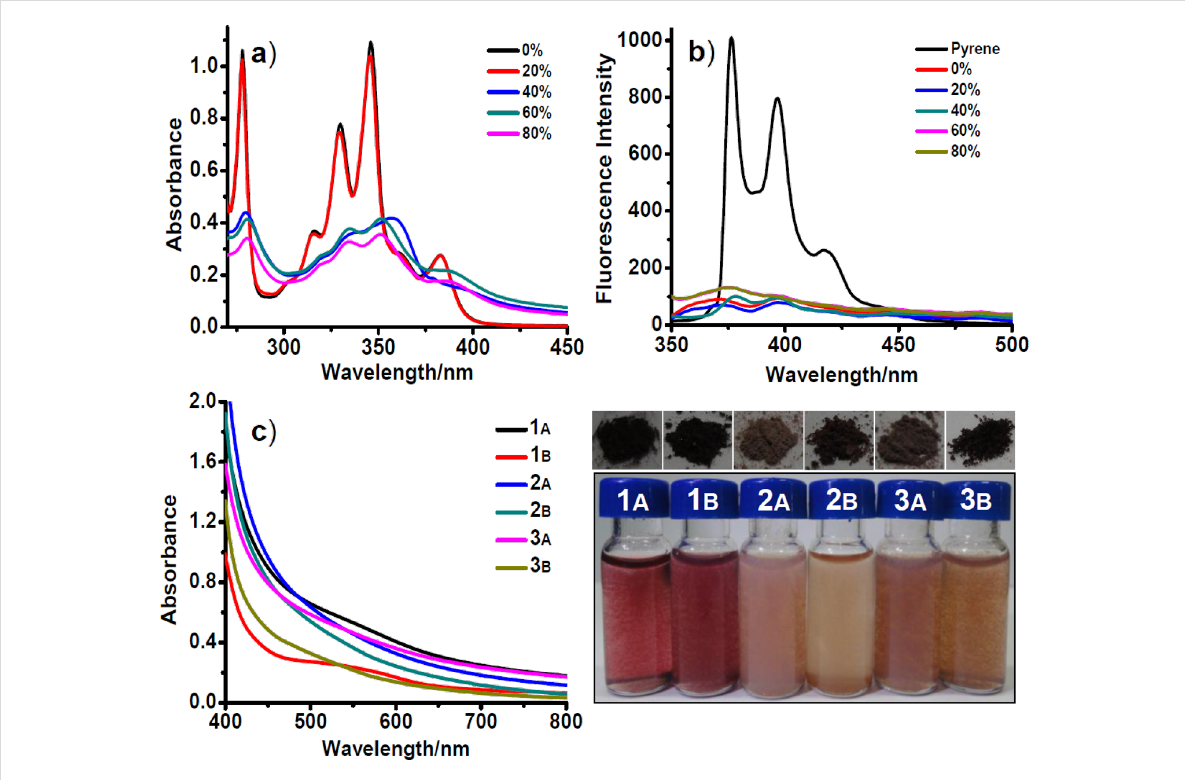
Figure 2: (a) UV–vis and (b) fluorescence spectra of 1 (200 μ M) in aqueous DMSO for various percentages of water in DMSO. Excitation at 345 nm. For comparison fluorescence emission spectra of pyrenemethylamine hydrochloride is shown (black trace, pyrene) in (b). (c) UV–vis spectra of 1 mM solutions of 1 , 2 and 3 in 40% aqueous DMSO/NMP show the charge-transfer bands. The photograph shows the solid-state and free-floating aggre- gates of 1 , 2 and 3 with their characteristic colours due to charge-transfer complexation. A: 40% aqueous DMSO. B: 40% aqueous NMP.